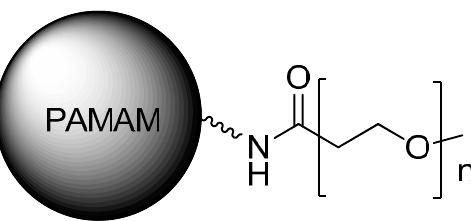
Figure 4. PEGylation of PAMAM is one of the strategies for decreasing its toxicity.